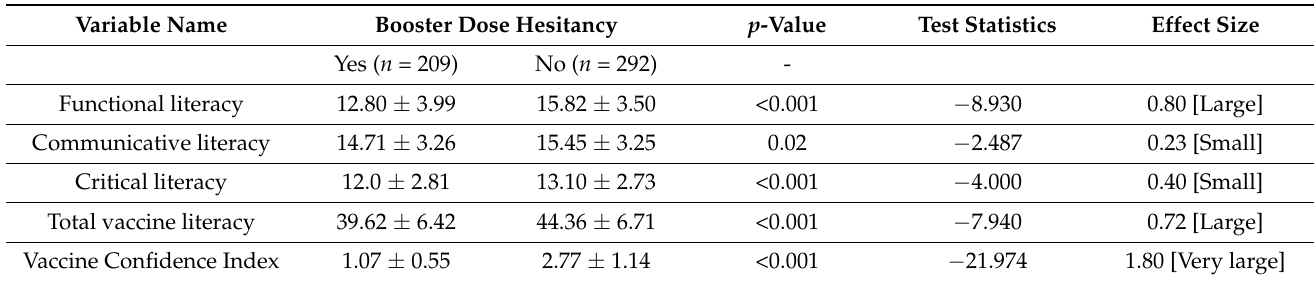
Table 3. Vaccine literacy and confidence among booster dose hesitant and non-hesitant groups ( N = 501).